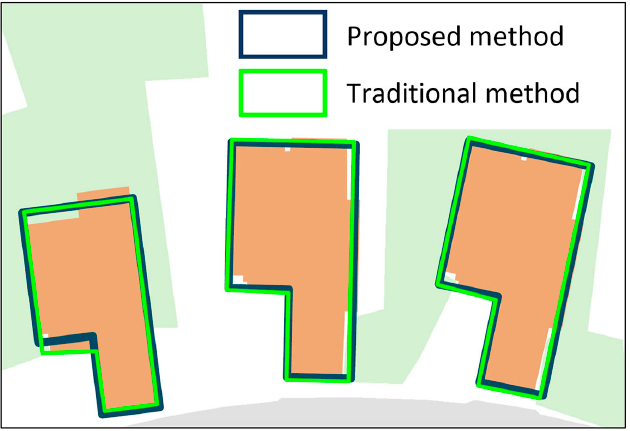
Figure 8. A contrastive analysis of the proposed method and a traditional method.